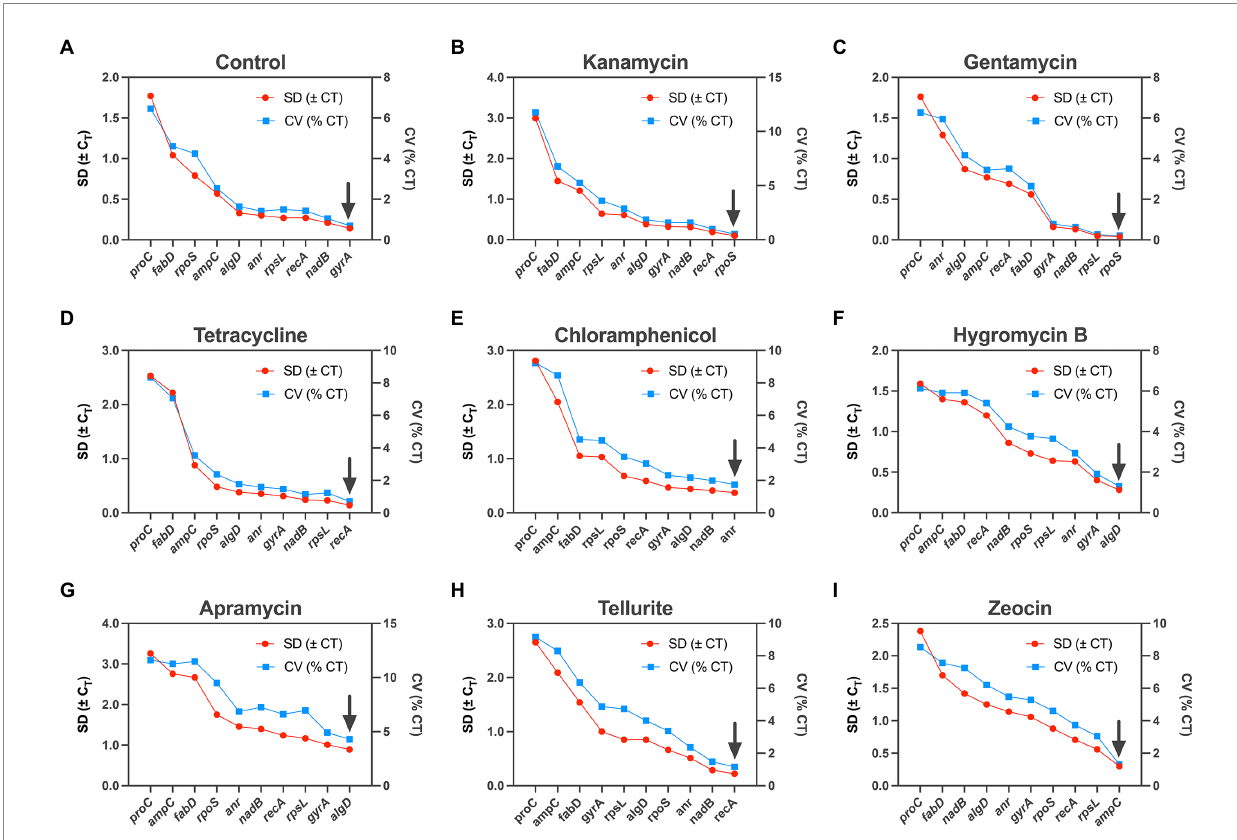
FIGURE 3 Expression analysis of 10 candidate housekeeping genes by BestKeeper algorithm. (A) Control; (B) kanamycin; (C) gentamycin; (D) tetracycline; (E) chloramphenicol; (F) hygromycin B; (G) apramycin; (H) tellurite; (I)